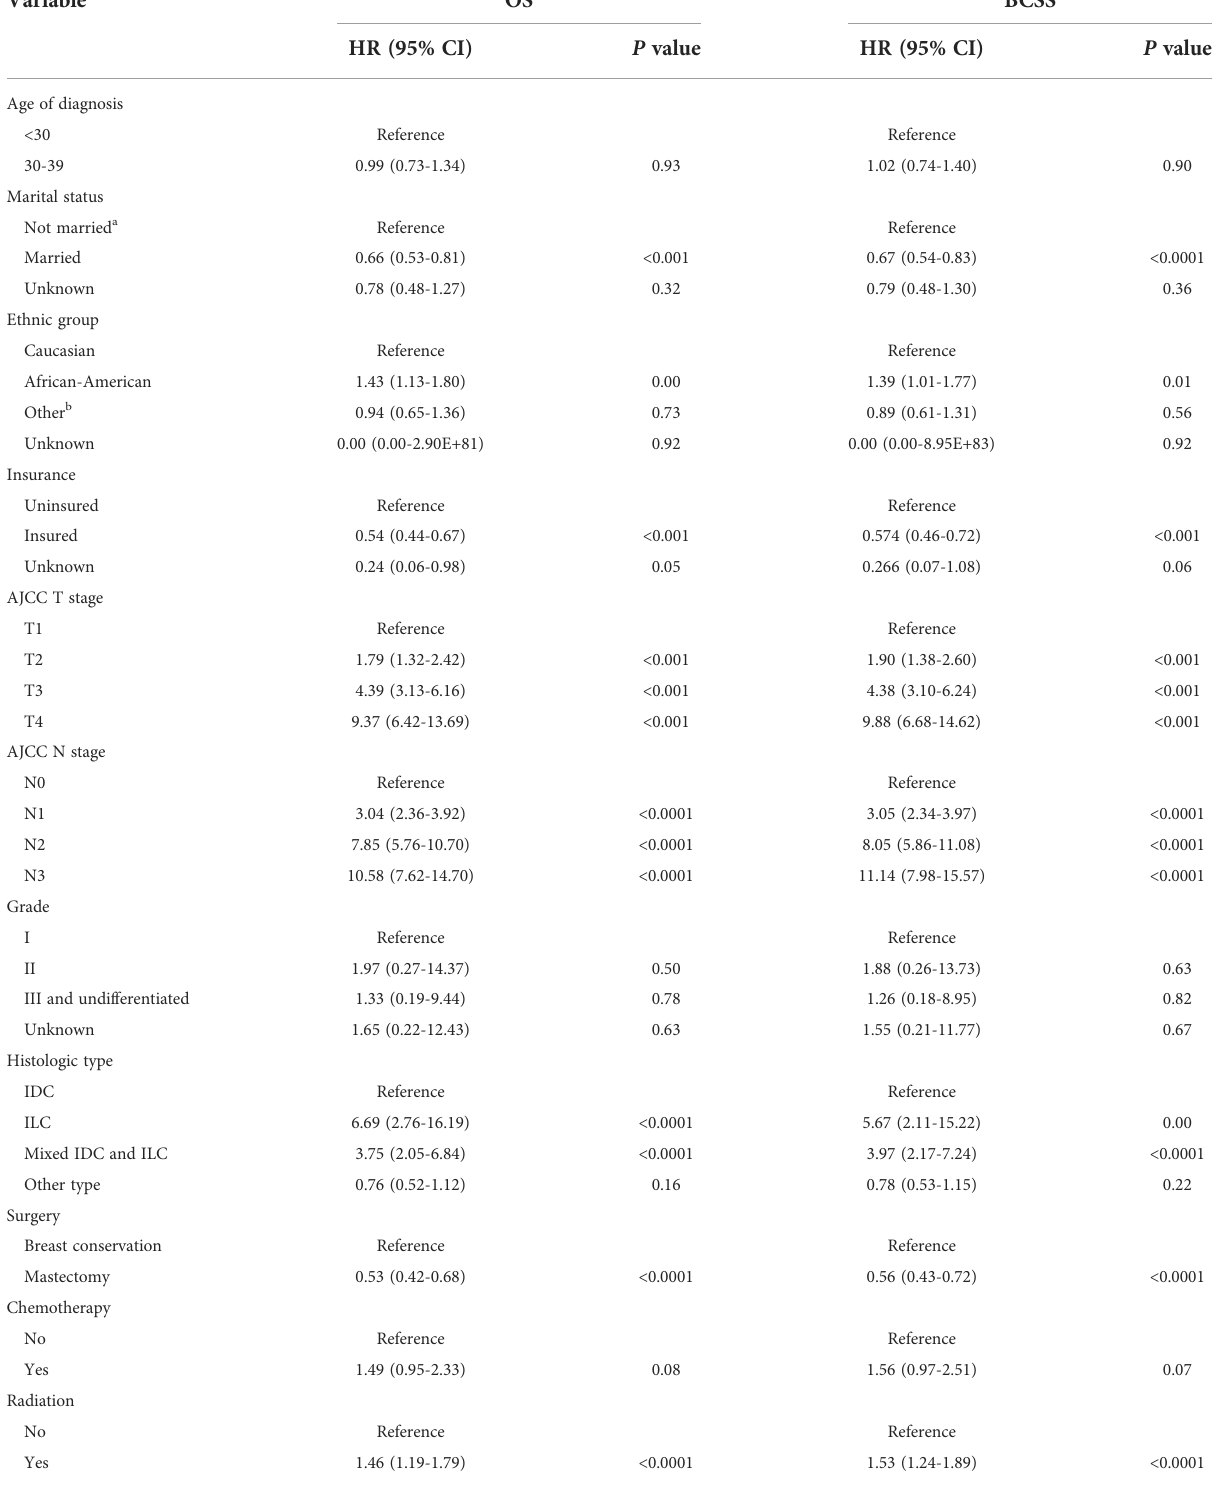
TABLE 1 Univariate analysis of factors potentially predictive of overall survival and breast cancer-speci fi c